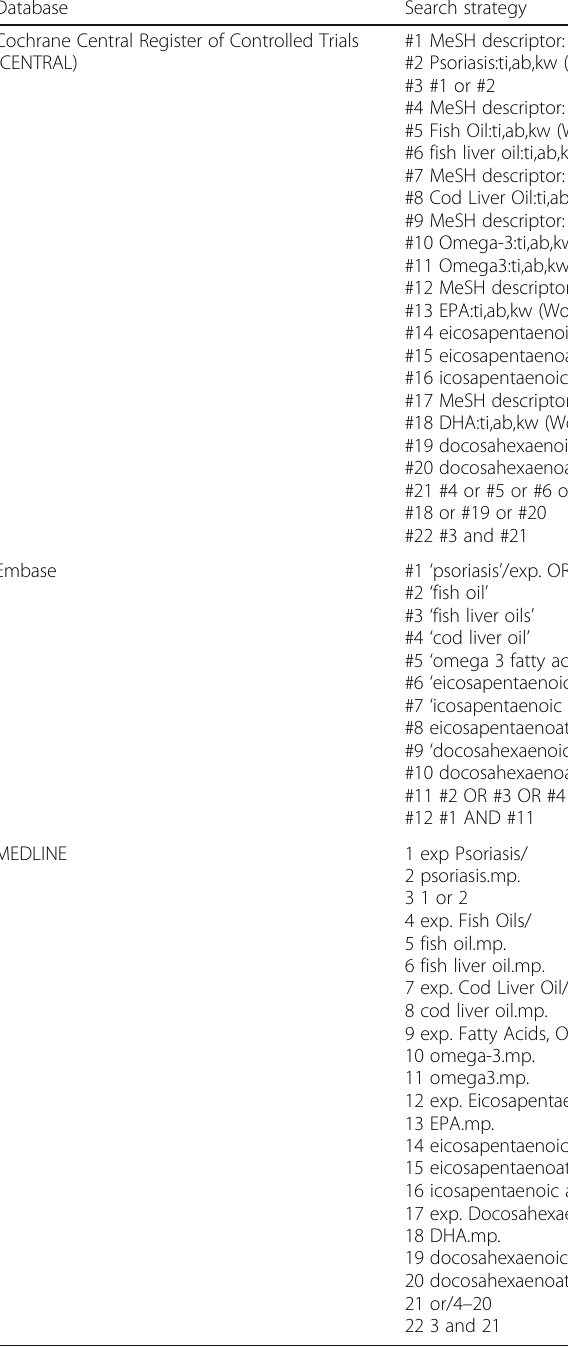
Table 1 Search strategy Database Search strategy Cochrane Central Register of Controlled Trials